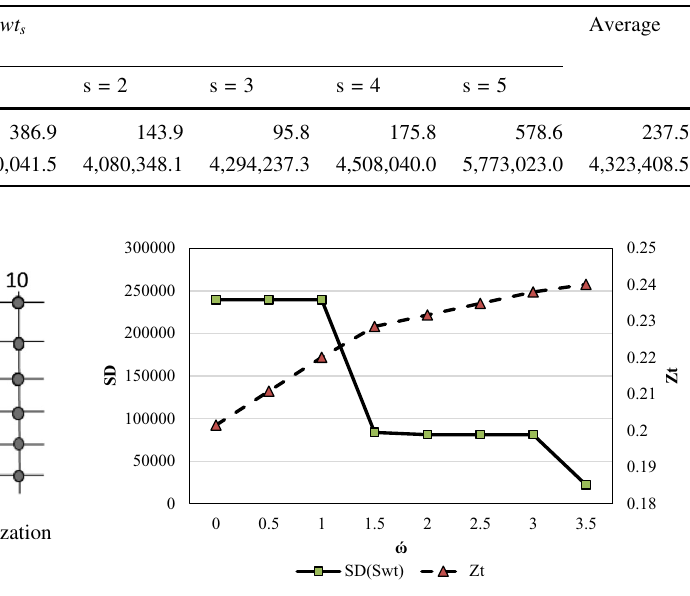
Fig. 6 Sensitivity analysis for standard deviation and waiting time under different